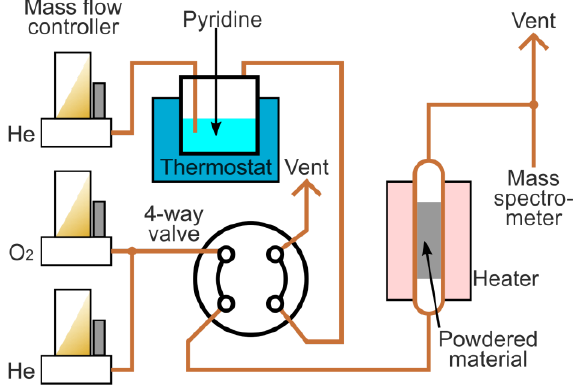
Figure 15. The scheme of the setup used for the pyridine chemisorption study.